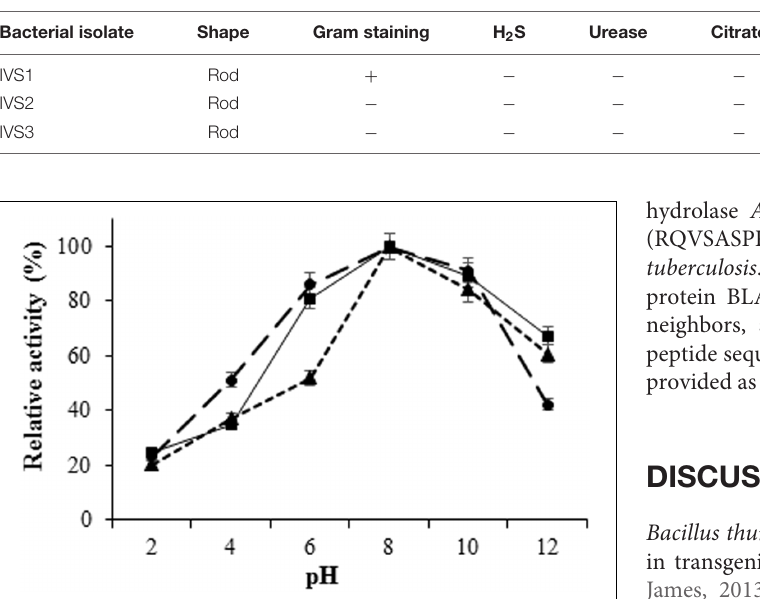
FIGURE 3 | Effect of pH on activity of proteases from gut bacteria in H. armigera . The midgut bacterial proteases were incubated with azocasein at different pH ranging from 2.0 to 12.0 and the total protease activity was measured. Total protease activity in ( (cid:4) ) IVS1, ( (cid:78) ) IVS2, and ( • ) IVS3 isolates was determined. Each value represents the average of three experiments.